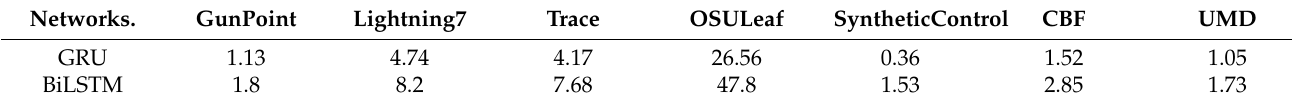
Table 3. Averaged time consumption of one epoch for different datasets (Unit: second).